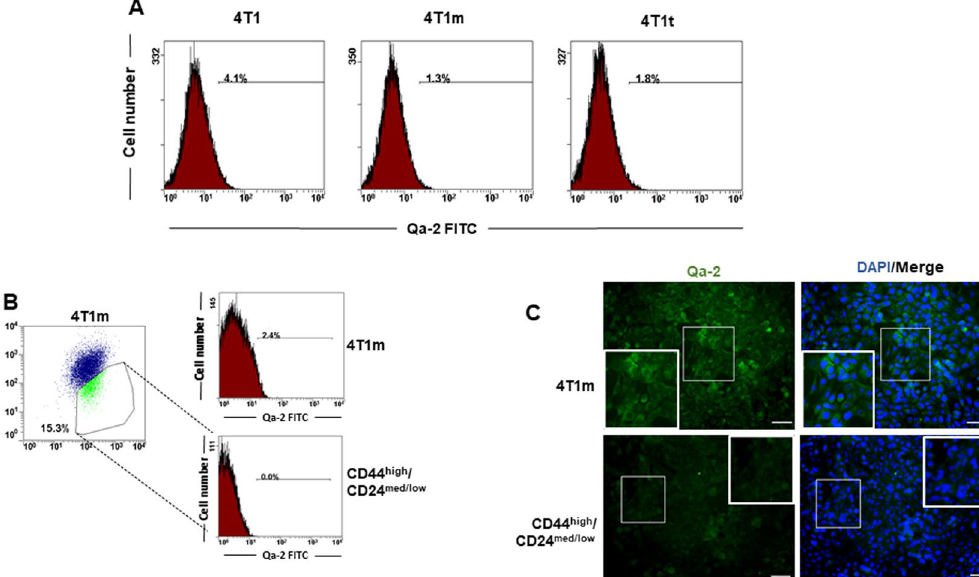
Figure 4. Cell lines derived from 4T1 tumors have reduced Qa-2 expression. ( A ) Analysis of Qa-2 cell-surface expression by flow cytometry. ( B ) The CD44 high /CD24 med/low cell subpopulation was isolated from 4T1m cells by FACS and the expression of Qa-2 determined in these cells (bottom panel) and in the total 4T1m cell population (upper panel). Note that Qa-2 expression in CD44 high /CD24 med/low cells is undetectable. ( C ) Immunofluorescence detection of Qa-2 in 4T1m and CD44 high /CD24 med/low cells. Nuclei were stained with DAPI. Bars, 100 μ m. Insets show increased magnifications of the indicated